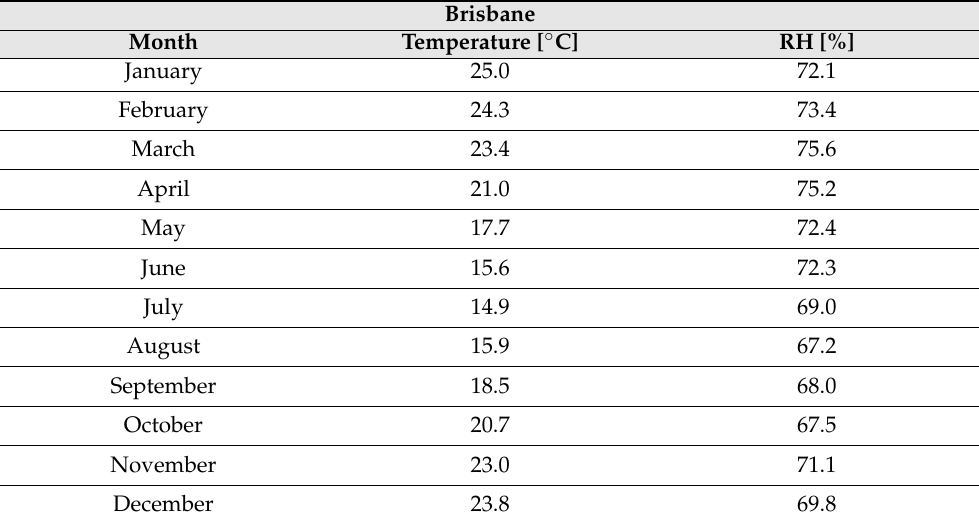
Table 11. Average weather data in